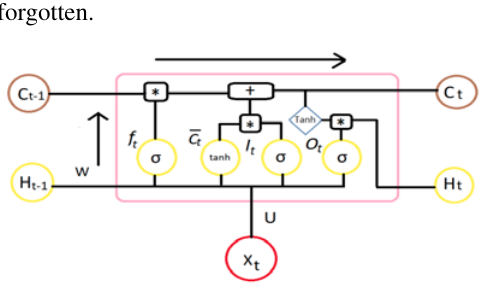
Table 1. Classification Report of Random Forest